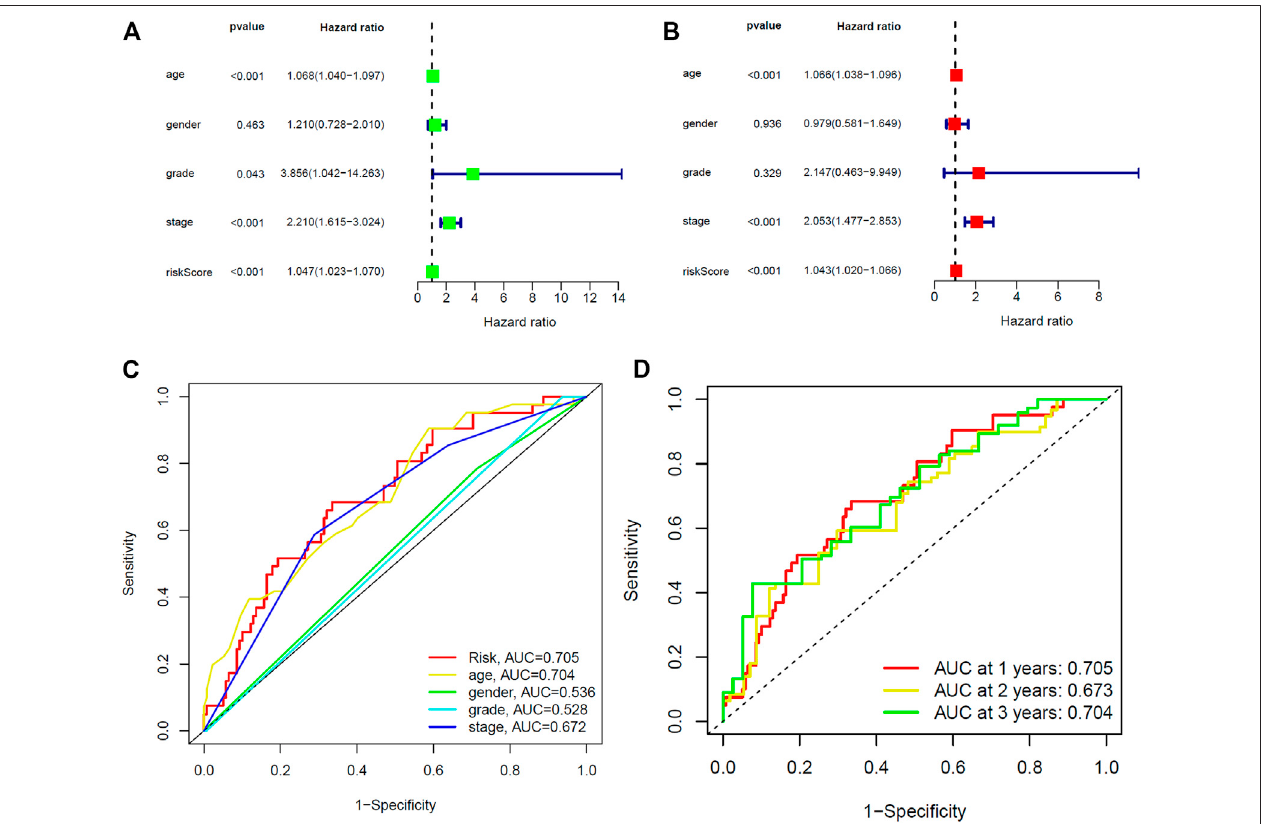
FIGURE5| Identi fi cationofprognosticindicatorsforbladdercancerintrainingset. (A) UnivariateCoxregressionanalysisshowedthatage,stageandtheriskscore wereprognosticfactors ofbladdercancer. (B) Age,stage, and theriskscore areindependent risk factors forbladdercancer. (C) ROCcurveofprognostic indicators for bladder cancer. (D) Time-dependent ROC curve of the risk score.